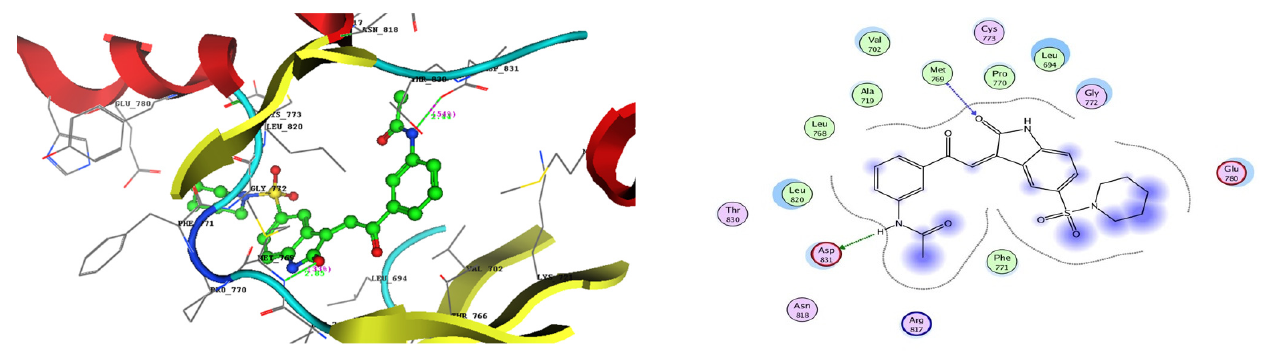
Figure 5. Molecular docking study: 3D and 2D interaction maps of the co-crystalized ligand (Erlotinib) ( A , B ), the positive control (doxorubicin) ( C , D ), and the isatin sulfonamide derivatives 3a , 4b , and 4c ( E – J ) inside the EGFR (PDB:1M17) active site. Table 5. Molecular docking study results of the isatin sulfonamide derivatives 3a , 4b , and 4c , doxorubicin, and the co-crystalized ligand (Erlotinib), with binding energy and inter-acting groups with specific amino acids in residue inside the active site of the EGFR (PDB: 1M17). Compound